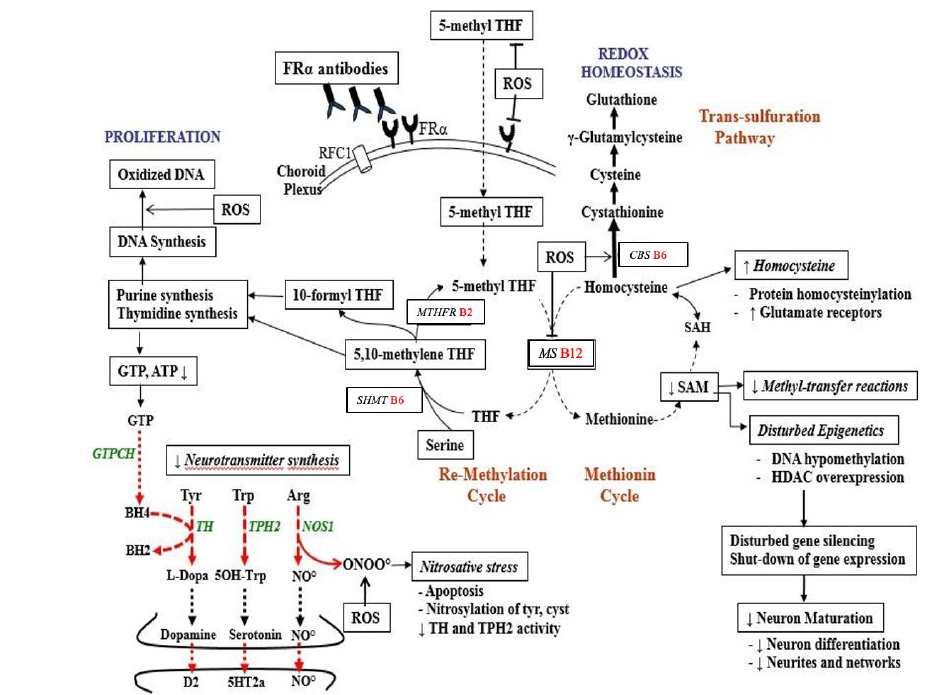
Figure 2. Pathways of folate metabolism after FR α mediated flux of 5-methyl-tetrahydrofolate (5- methyl THF) across the choroid plexus into the CSF and then to the brain. Inside neurons, most methyl-THF will be stored while a proportion actively participates in metabolism. Methyl-THF transfers its methyl group to the B12-dependent methionine synthase (MS) enzyme, converting homocysteine to methionine. In the methionine cycle methionine is the precursor of the universal methyl-donor SAM, used in more than 100 methylation reactions. In the remethylation cycle, tetrahy- drofolate (THF) receives a mono-carbon group from serine and is converted to 5,10-methylene THF. Part of 5,10-methylene THF is reduced by methylene-THF reductase (MTHFR B2) to 5-methyl-THF, while another portion is used to produce thymidine or is converted to 10-formyl THF, needed for purine synthesis. On the left side of the picture, the purine metabolite GTP serves as substrate for the GTP-cyclohydrolase I enzyme (GTPCH) to produce tetrahydrobiopterin (BH4), which is the co-factor for enzymes producing dopamine, serotonin and NO. At the upper right of the figure the